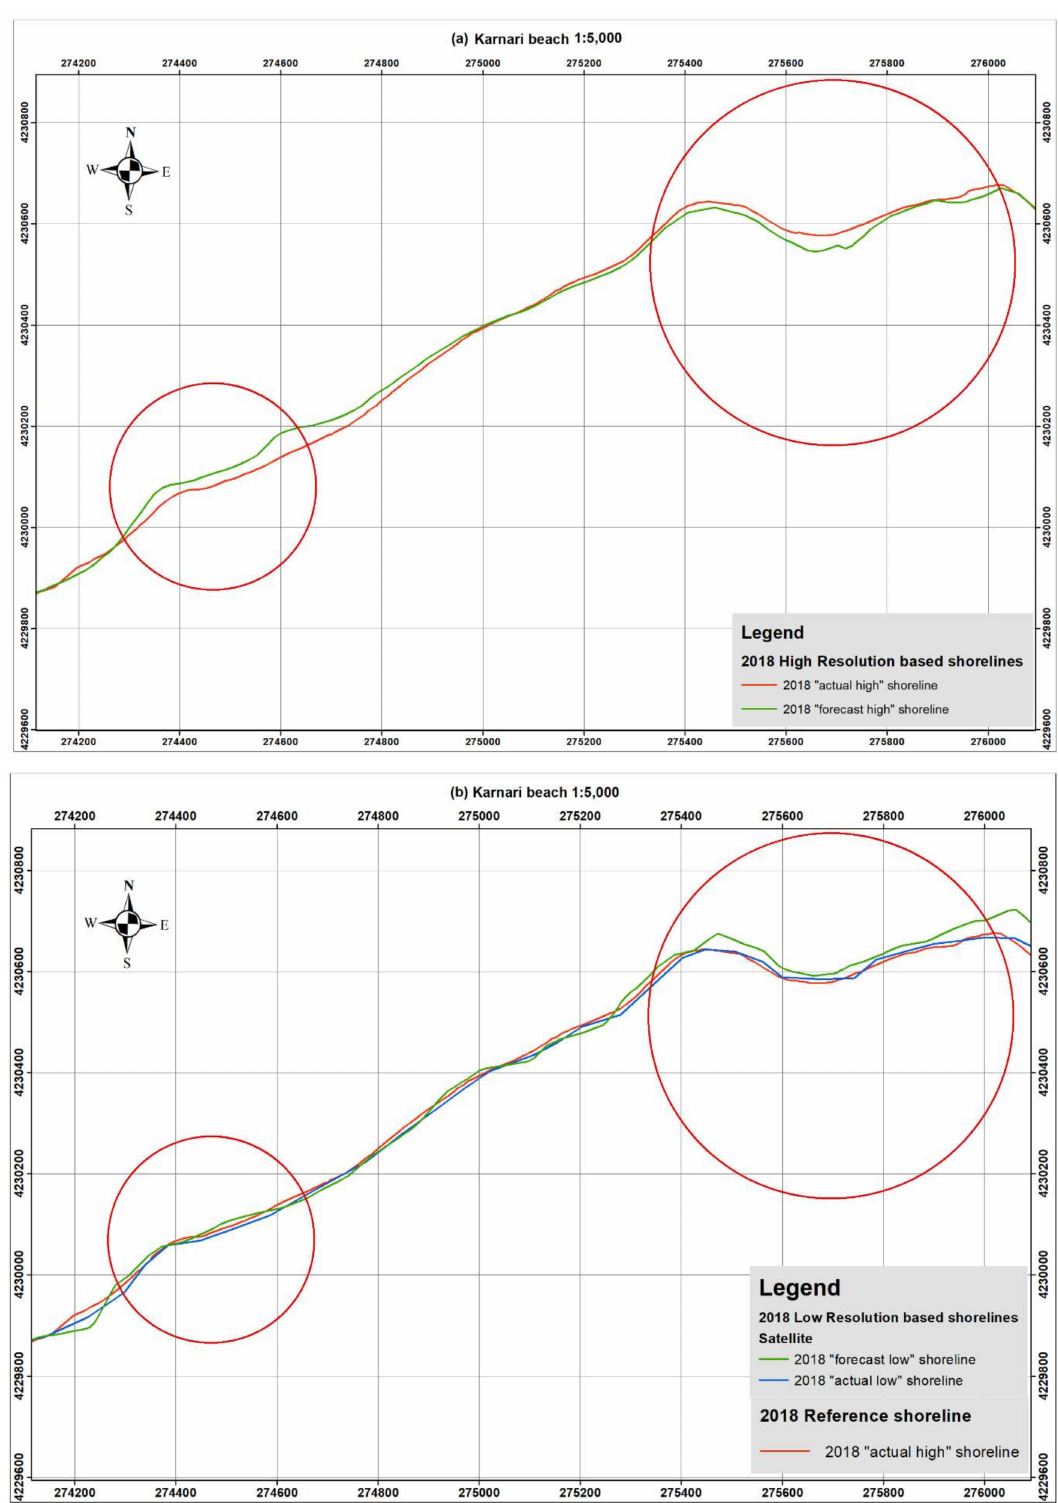
Figure 5. Shorelines of 2018 overlapping at a high scale based on high- and low-resolution images for Karnari beach. Red cycles demonstrate areas where the deviation in the low-resolution data is obvious in high-scale